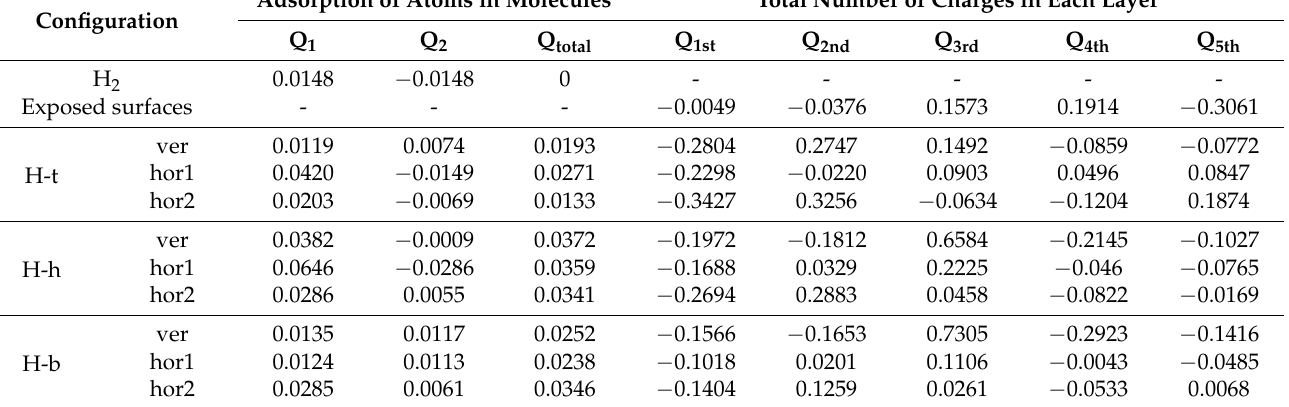
Table 2. Net charge distribution after optimization of each adsorption configuration (Q1 and Q2 represent the amount of charge transferred between the two hydrogens. Q total = Q 1 + Q 2 . Q 1st , Q 2nd , Q 3rd , Q 4th , and Q 5th represent the total amount of transferred charge of atoms at the 1–5 layers on the